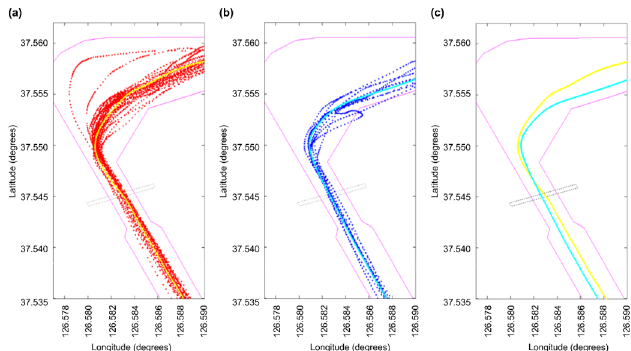
Figure 8. Representative track model extraction results: ( a ) flood current; ( b ) ebb current; ( c ) flood current vs. ebb current.